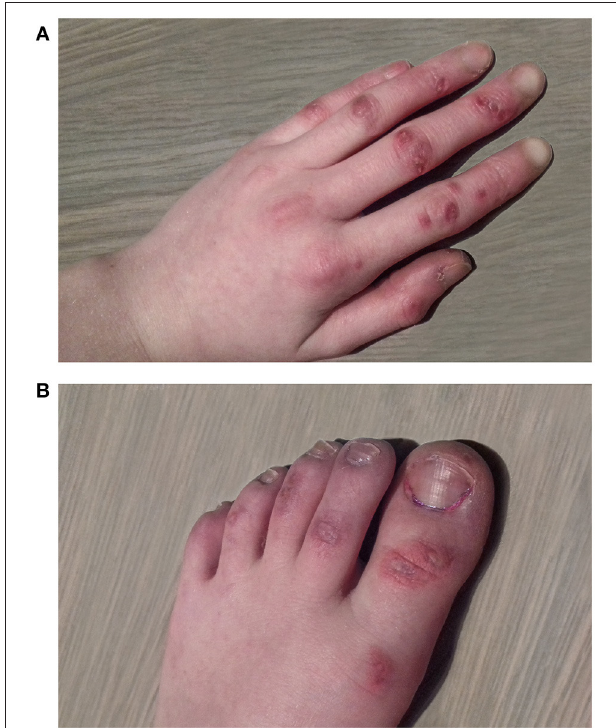
FIGURE 1 | Brain MRI findings in our AGS patients: (A) Periventricular and frontoparietal lesions suggestive of cortical and white matter infarctions associated with (B) moyamoya disease at the distal left internal carotid artery and the proximal right middle cerebral artery on MR angiography in patient 1. (C) Isolated posterior thinning of the corpus callosum in patient 2. (D) Bilateral frontal periventricular microcysts and diffuse white matter hyperintensities in patient 3.